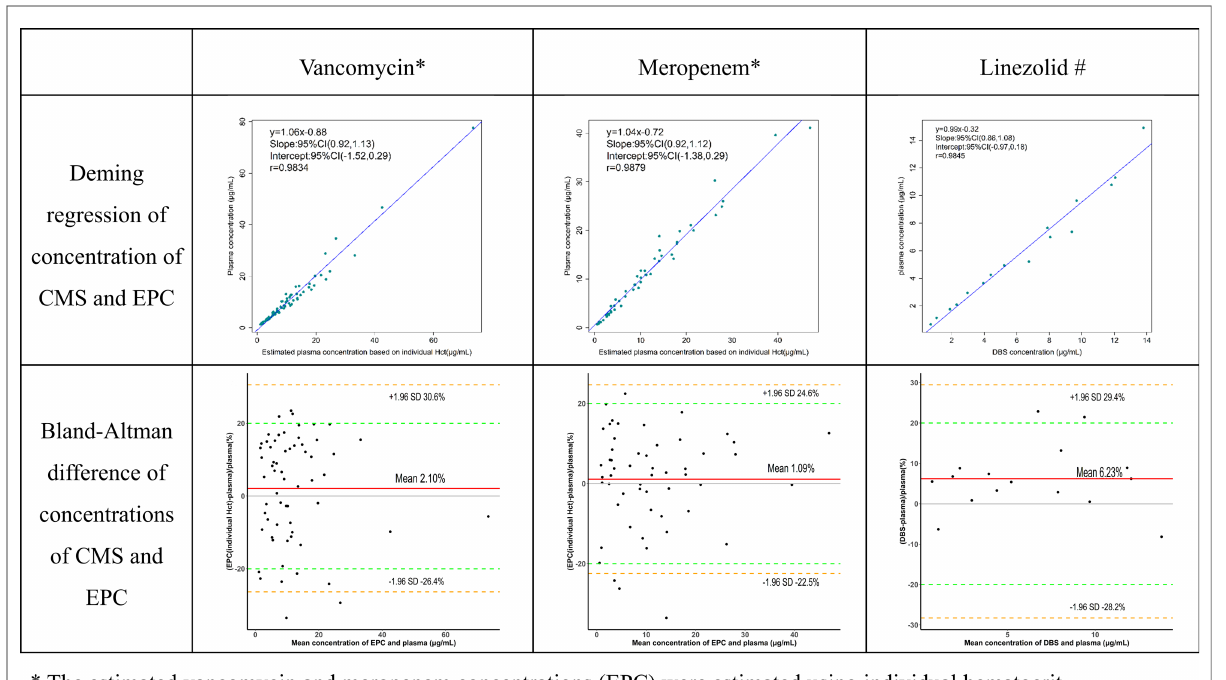
FIGURE 3 Agreement of three antibiotic concentrations between capillary microsamples and DBS